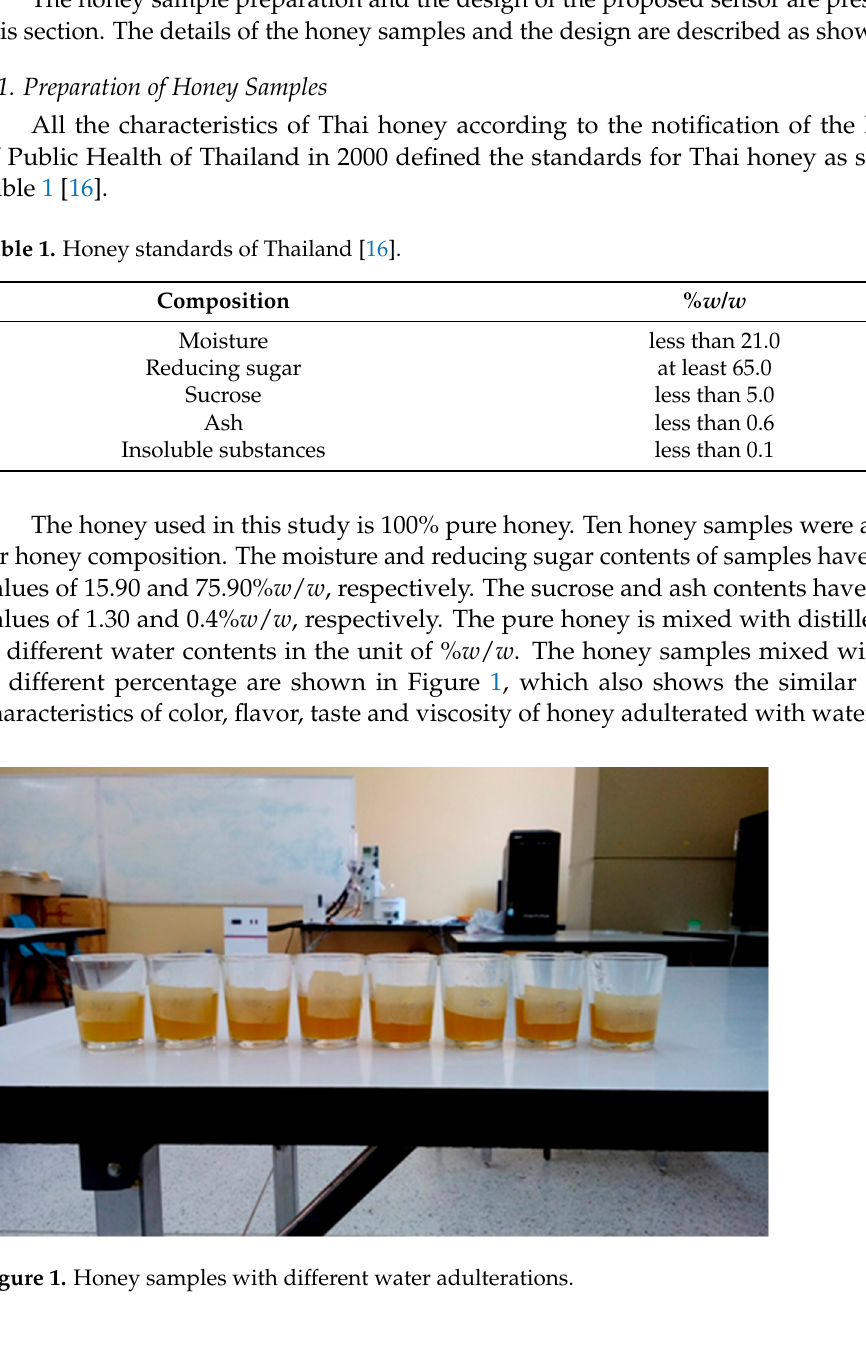
Figure 2. A photograph of SMA connectors. The sensor used with the honey samples is a modified SMA connector. The low-cost modification involves trimming the pins to be an open-ended coaxial sensor, which can measure the complex relative permittivity of materials. Also, the results can be used to calculate the electrical conductivity, and the phase constant. The structure of the proposed sensor is shown in Figure 3.